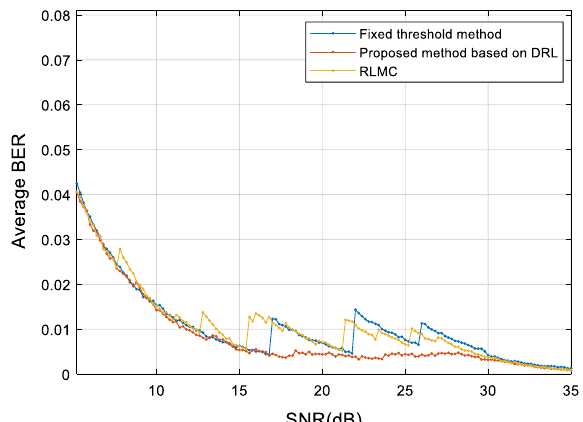
Fig. 13 Average BER in simulated